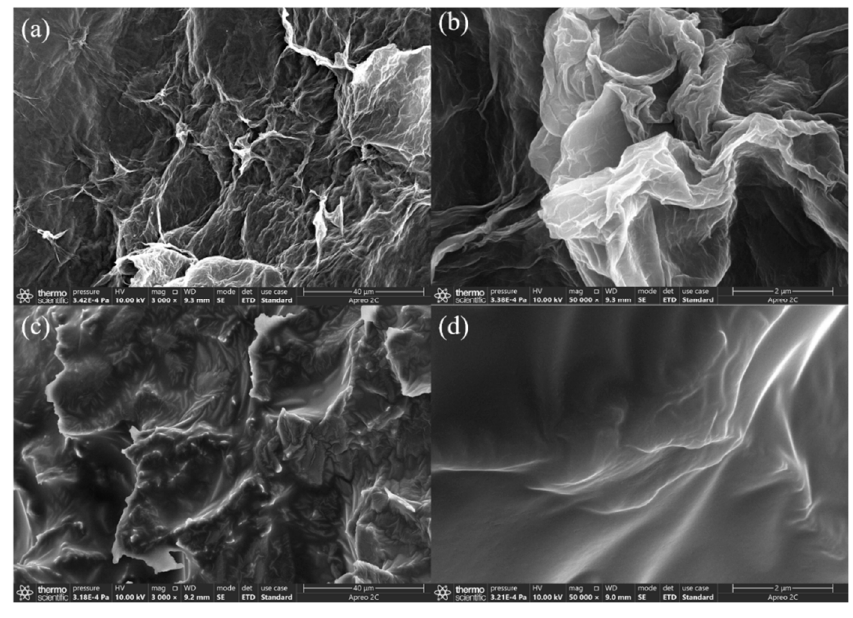
Figure 7. Scanning electron microscope (SEM) of raw GA and PDMS/GA. ( a ) and ( b ) is SEM of GA; ( c ) and ( d ) is SEM of PDMS/GA.